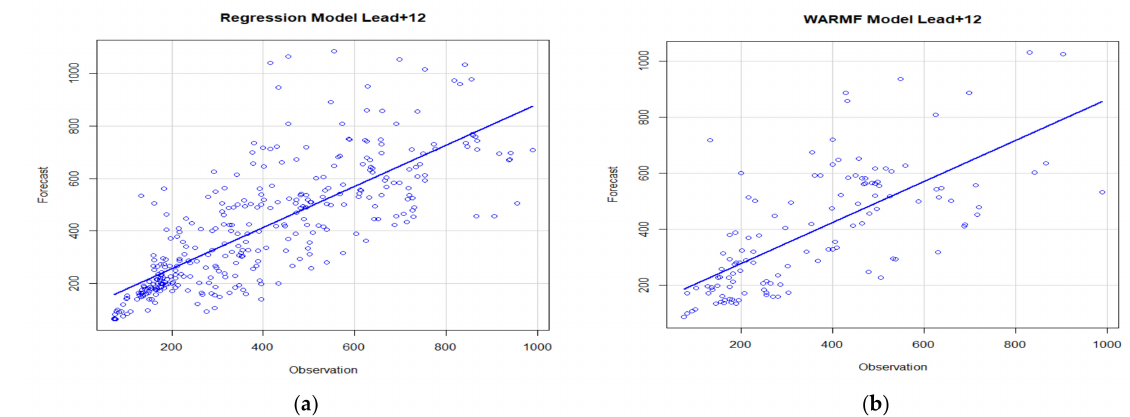
Figure 14. ( a , b ). Calculated linear regression relationship (solid blue line) for the Regression ( a ) and WARMF ( b ) models together with a scatterplot of the underlying observed EC data and model forecast EC for lead time ∆ Day +